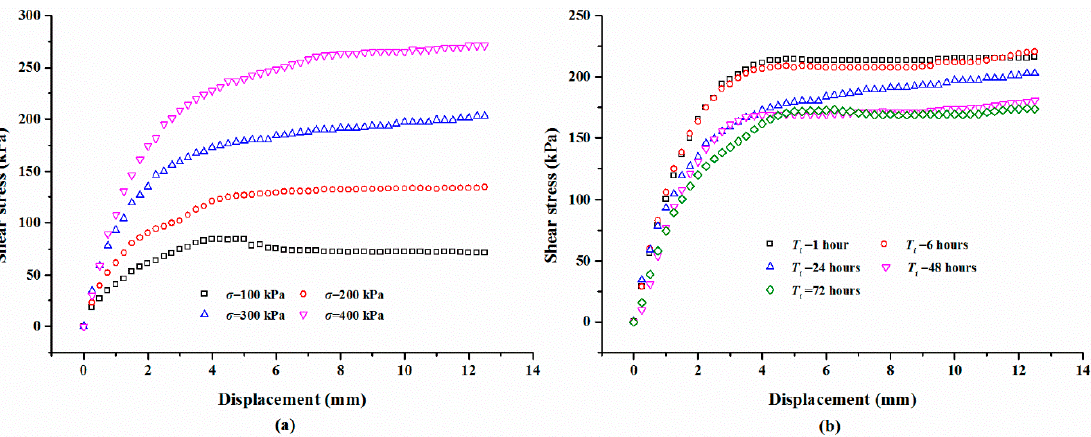
Figure 8. The presentative shear stress-displacement curves: ( a ) With different normal stress σ ; ( b ) With different immersion time T i . Polymers 2018 , 10 , x FOR PEER REVIEW